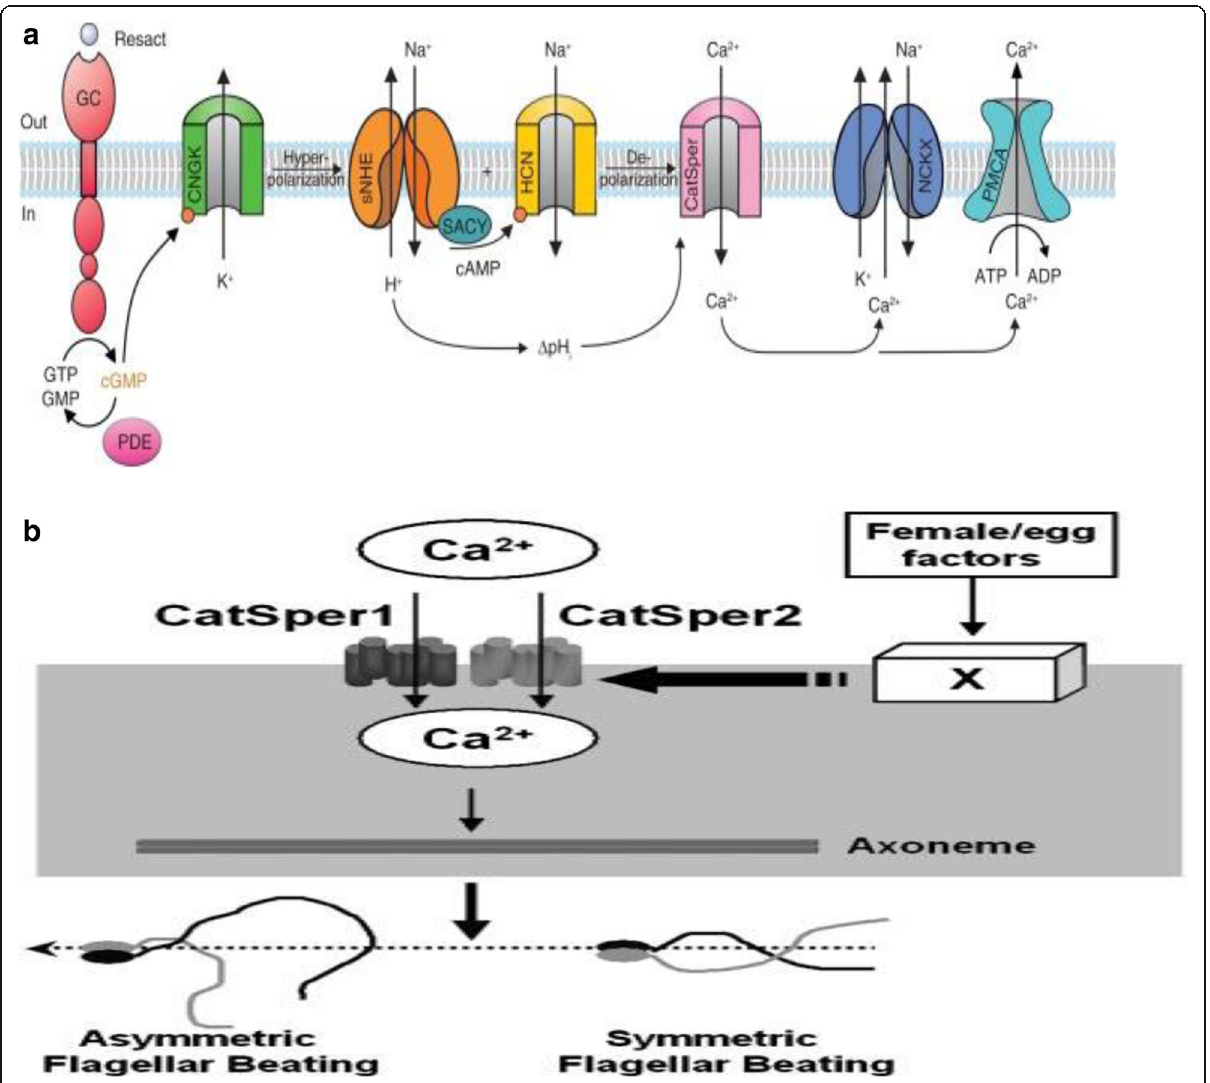
Fig. 4 a Overview of the signaling cascade underlining sperm chemotaxis behavior (adapted from [95]). b Influence of increased intracellular calcium in flagellar